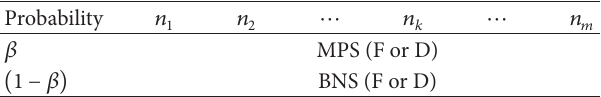
T 4: �niform strategy pro�le of MPS-BNS as pure strategy.